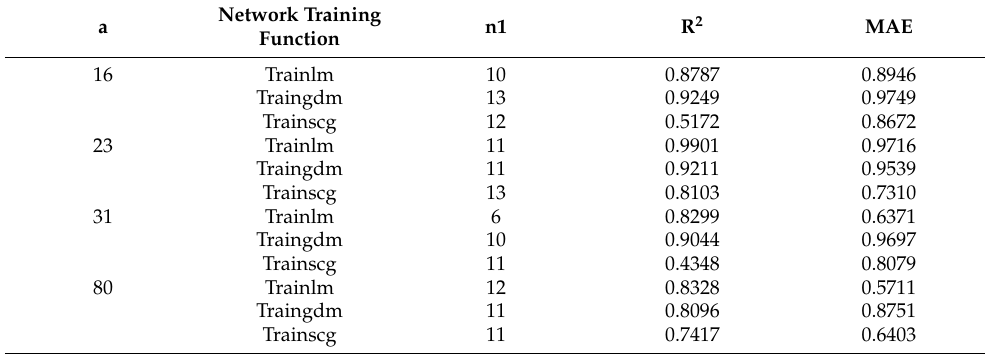
Table 11. Model prediction